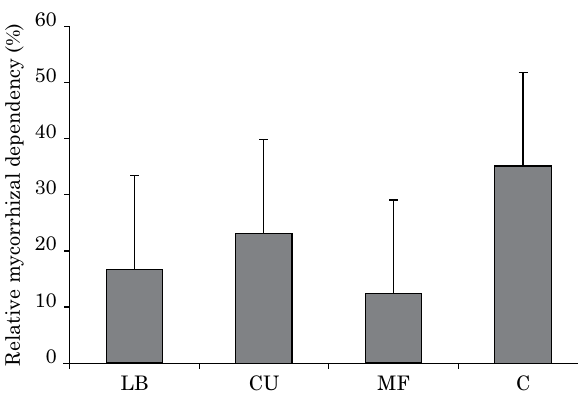
Figure 3. Relative mycorrhizal dependency (RMD) as a function of the fertilization treatments. Vertical bars indicate LSD 0.05 for fertilization treatments. LB: liquid biofertilizer, CU: cow urine, MF: mineral fertilizer, and C: unfertilized treatment -